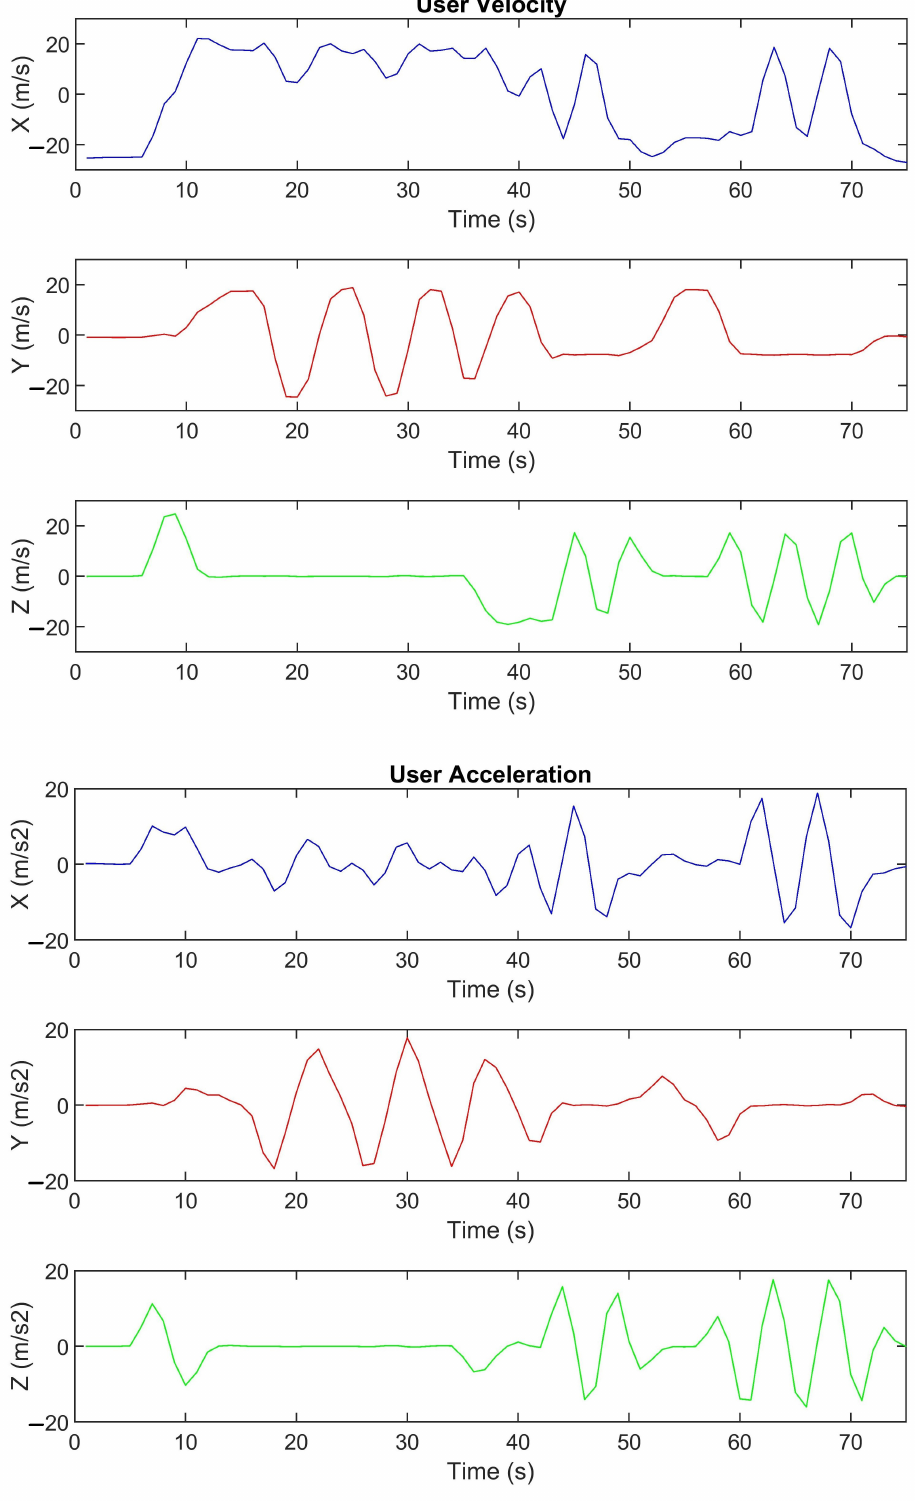
Figure 9. Instantaneous user velocity and acceleration components during each rollercoaster cycle. The coordinate system follows the convention used in Unity, i.e., X: right direction; Y: up direction; Z: forward direction. Seesaw motion: 8–32 s; spiral motion: 36–44 s and 48–64